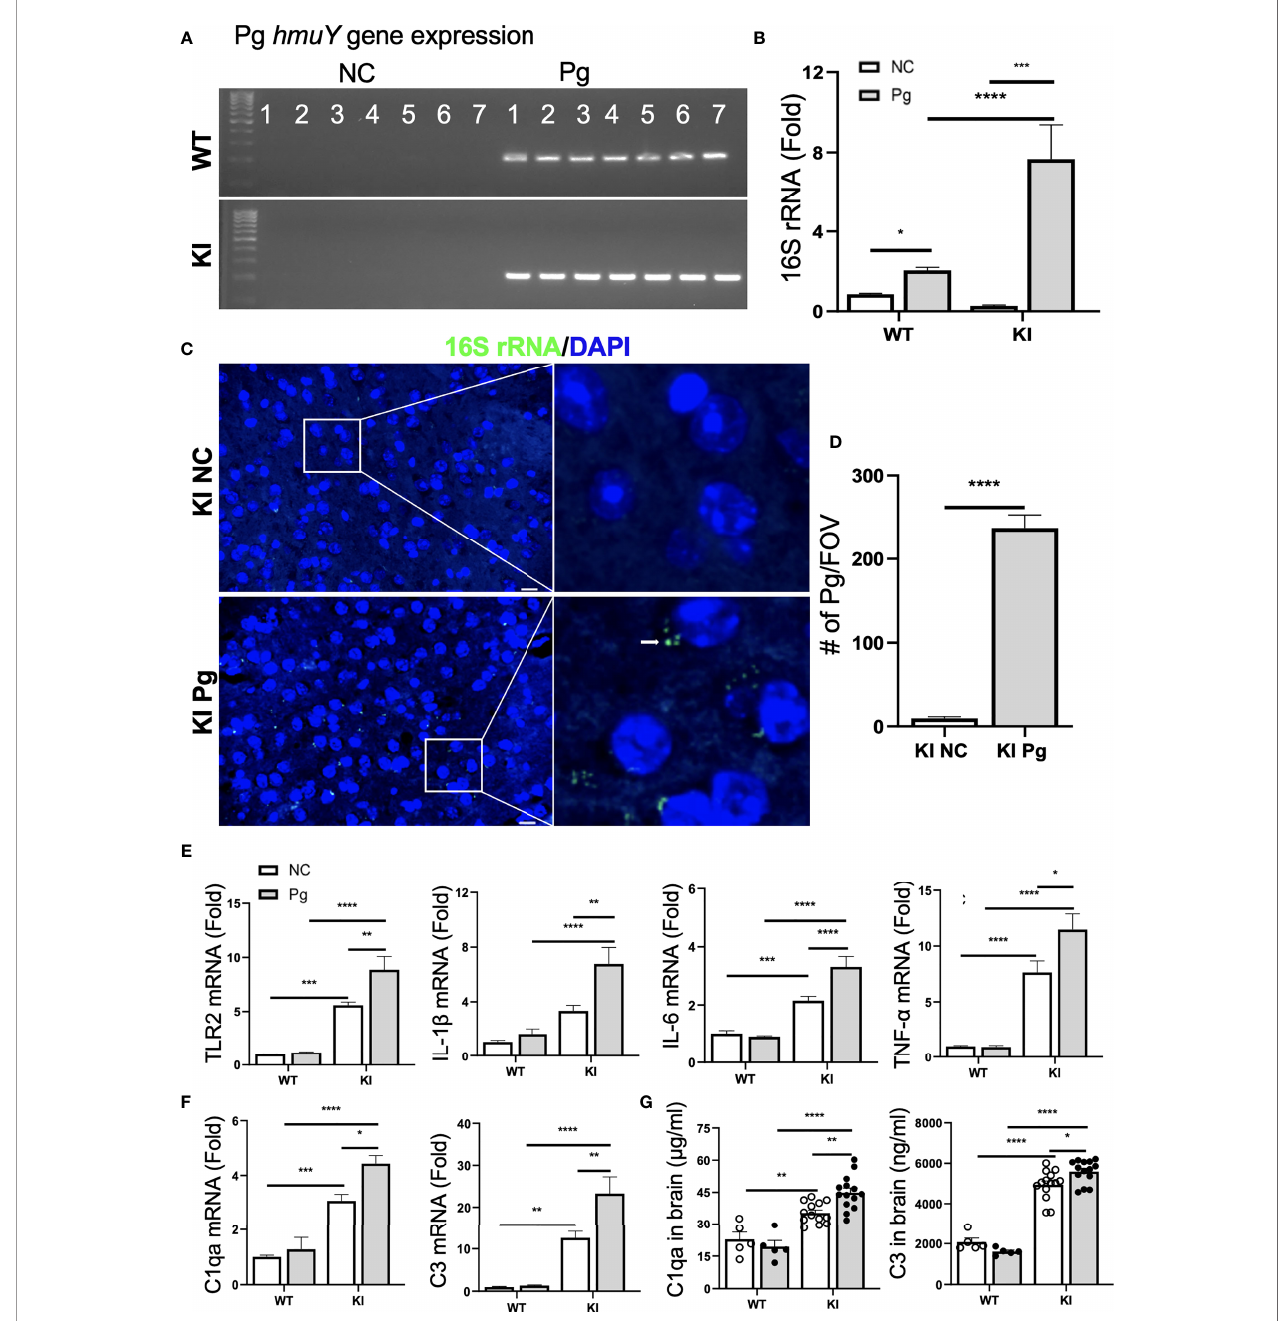
FIGURE 4 | Pg invades the brain and induces neuroin fl ammation and complement activation. (A) Pg-speci fi c h muY gene expression in brains from WT and App KI mice. (B) Pg-speci fi c 16S rRNA expression in brains from WT and App KI mice. The levels of gene expression were normalized to GAPDH and shown as fold changes. Samples were run in duplicates (n=7/group). (C) Representative micrographs depicting intracellular localization of Pg in the cortex of brains from App KI mice. Pg were probed with 16S rRNA with FITC (green, arrowhead) and nuclei were labeled with DAPI (blue). Boxed areas were further enlarged. Scale bar, 10 µm. (D) Quanti fi cation of Pg in brain sections from non-infected and Pg-infected App KI mice. Five representative regions were captured at 40 x objective from each brain section and quanti fi ed (n=5-7/group); FOV, fi eld of view. (E) The relative gene expression of in fl ammatory cytokines and TLR2 in brain tissues from WT and App KI mice. Samples were done in duplicates (n=5-7/group). (F) The relative gene expression of C1qa and C3 in brain tissues from WT and App KI mice. Samples were run in duplicates (n=5-7/group). (G) The levels of C1qa and C3 in the brains of WT and App KI mice. Samples were run in duplicates (WT mice, n=5-7/group; App KI mice, n=10-12/group). Data are expressed as mean ± SEM; * P < 0.05, ** P < 0.01, *** P < 0.001, **** P < 0.0001 by two-way ANOVA followed with Tukey correction (B, E – G) or by unpaired Student t -test (D)